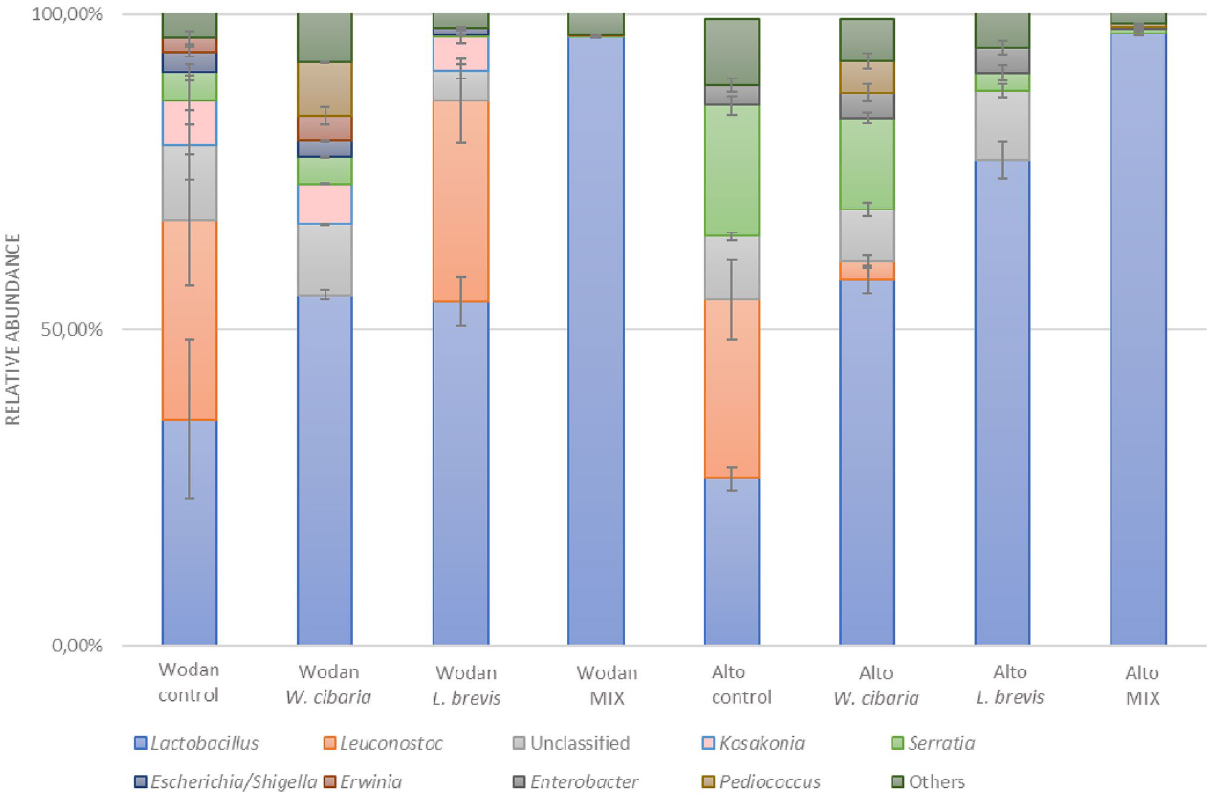
Figure 2. The microbial community of fermented juices of Wodan and Alto variety at the genus level revealed by high-throughput sequencing. Control denotes spontaneously fermented samples. A relative abundance of bacteria genera accounted for below 1% has not been shown. The name Lactobacillus refers to the old nomenclature, and therefore acc. to the current classification it includes 25 genera i.a. Lactobacillus , Lacticaseibacillus , Lactiplantibacillus (including L. plantarum ), Levilactobacillus (including L. brevis ), Limosilactobacillus (including L. fermentum ) 25 .